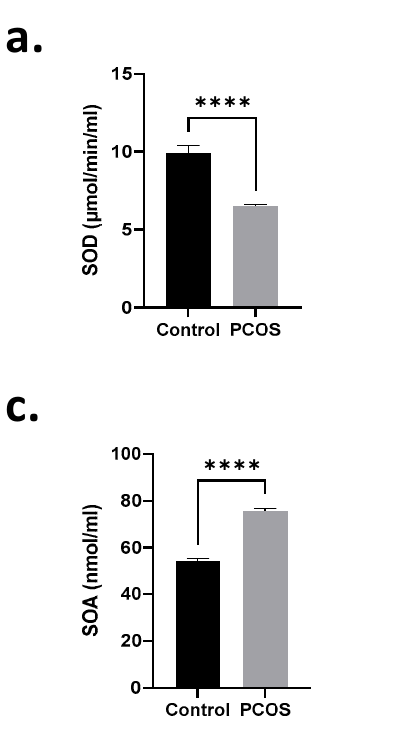
Figure 3. Serum SOD and CAT enzyme activities are inhibited in PCOS patients. Means ± SEM of ( a ) SOD and ( b ) CAT activities and ( c ) SOA and ( d ) H 2 O 2 levels. **** p < 0.0001.